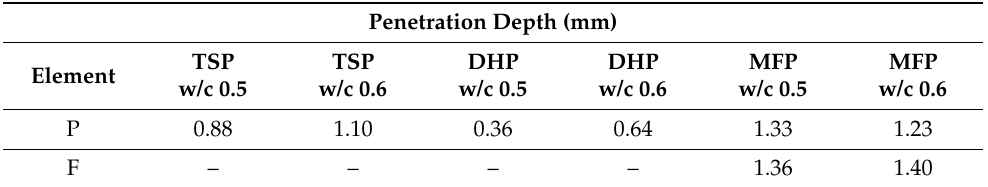
Table 4. Penetration depth for P and F in mortar specimens immersed in 5 wt.% Na 3 PO 4 · H 2 O (TSP),